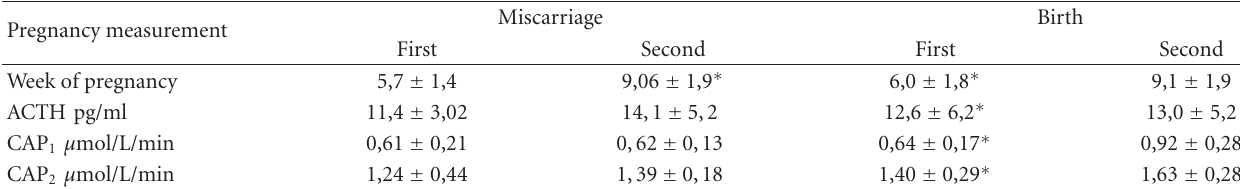
Table 1: The results of the first laboratory examinations of women with miscarriages and births. Miscarriage Birth Pregnancy measurement First Second First Second Week of pregnancy 5,7 ± 1,4 9,06 ± 1,9 ∗ 6,0 ± 1,8 ∗ 9,1 ± 1,9 ACTH pg/ml 11,4 ± 3,02 14,1 ± 5,2 12,6 ± 6,2 ∗ 13,0 ± 5,2 CAP 1 μ mol/L/min 0,61 ± 0,21 0,62 ± 0,13 0,64 ± 0,17 ∗ 0,92 ± 0,28 CAP 2 μ mol/L/min 1,24 ±